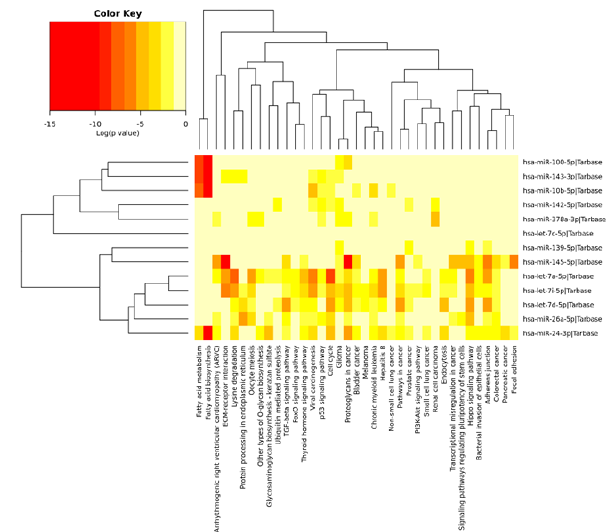
Figure 5. Venn diagram of di ff erentially-expressed miRNAs in subcutaneous fat tissue dependent on fat content in three analyzed breeds (LW, Large White; Pi, Pietrain; and Hp, Hampshire).